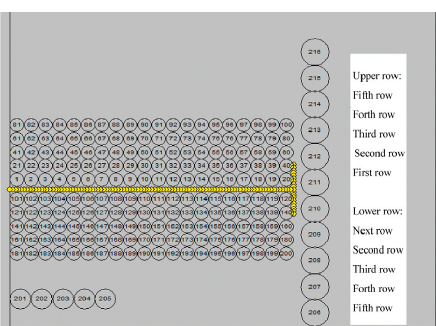
Figure 14: Contact stress before loading.